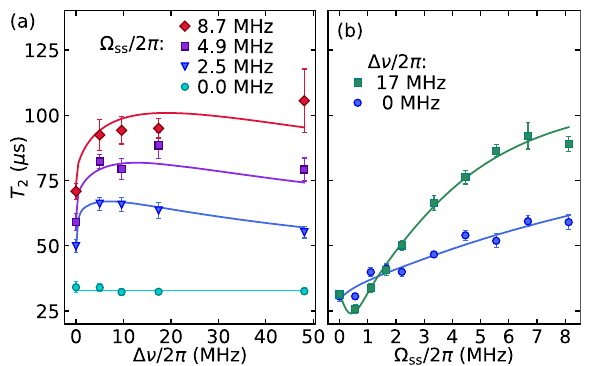
Fig. 4 Coherence time for different driving parameters. a NV T 2 as a function of Δ ν for different bath Rabi frequencies Ω ss . Stochastic drive outperforms monochromatic drive ( Δ ν = 0). For very weak driving fi elds ( Ω ss /2 π = 0.0 MHz), the stochastic phase modulation is ineffective and T 2 is independent of Δ ν . b T 2 as a function of drive Rabi frequency Ω ss for monochromatic driving Δ ν = 0 and stochastic driving with Δ ν /2 π = 17 MHz. Solid lines are fi t using our model (see Supplementary Note 3 for details). Error bars correspond to ± one standard deviation of the T2